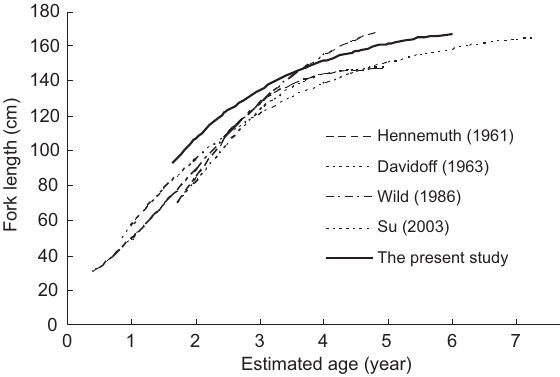
Figure6. Comparison of the growth curve for yellowfin tuna in- habiting the eastern and central Pacific Ocean estimated in the present study (heavy solid line) with the growth curves estimated by other authors.